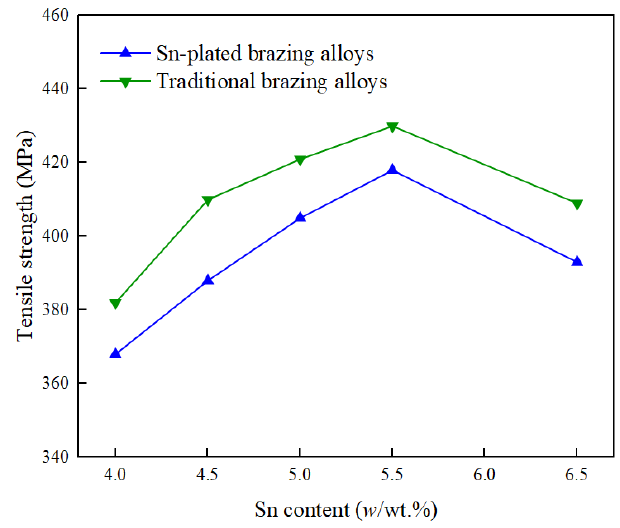
Figure 11. Tensile strengths of 316LN stainless steel joints brazed using BAg34CuZnSn filler metals with a plated Sn coating and a filler metal of the same composition but manufactured through the traditional melting and drawing processes [41].